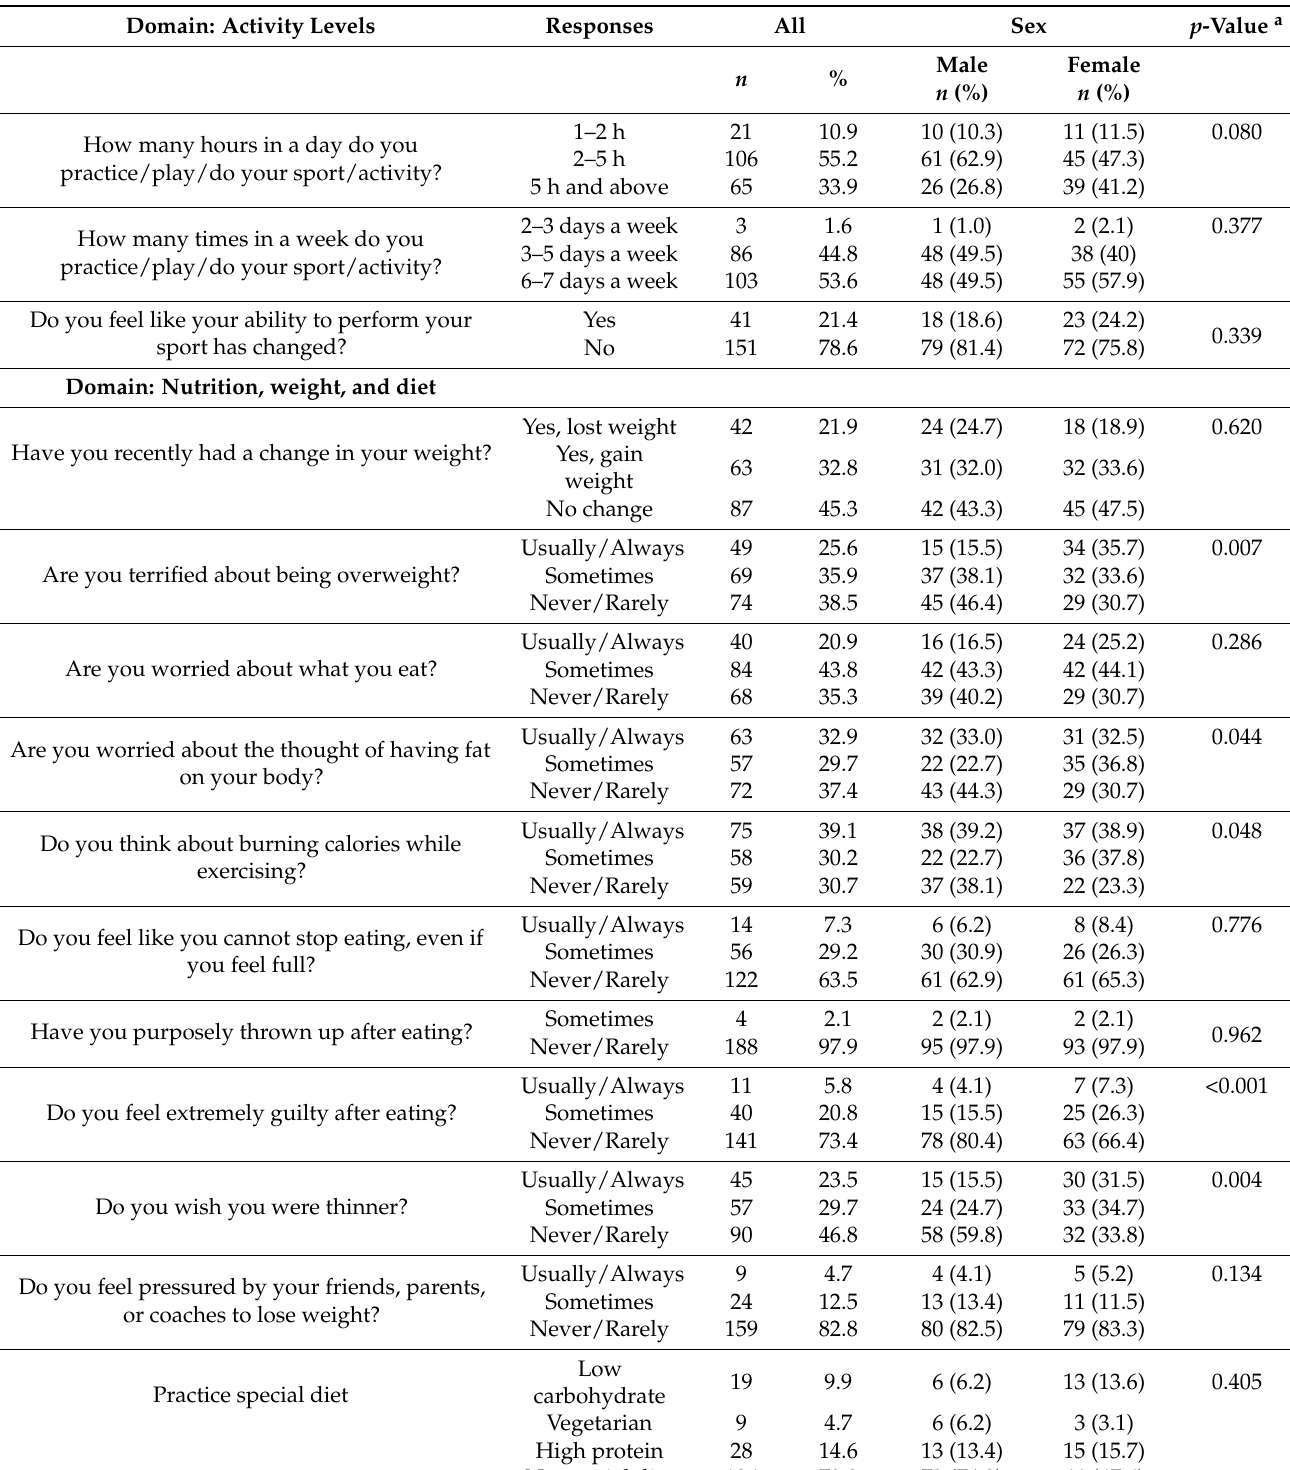
Table 3. Responses on activity levels, nutrition, weight and diet